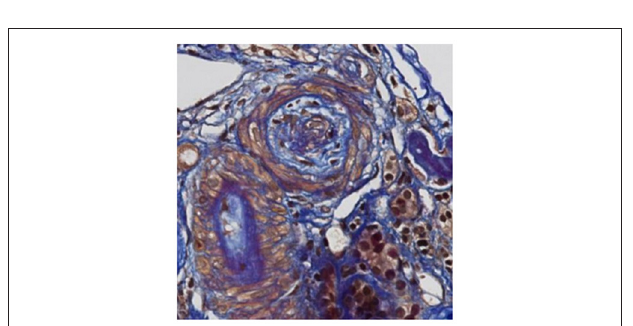
FIGURE 2 | Light microscopy. Later changes of thrombotic microangiopathy: the artery contains fibro-oedema with few collagen fibers within intima revealed in blue with trichome FAOG (FAOG, 400x).